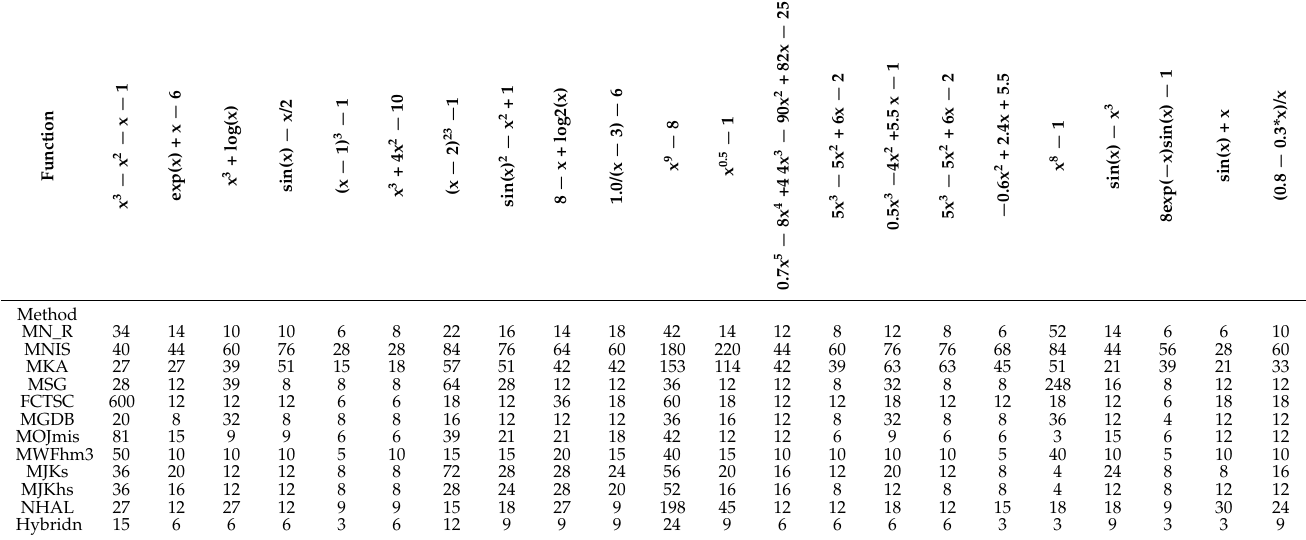
Table 2. One Parameter. Comparison of overall number of function evaluations (NOFE) in hybrid algorithm and all other algorithms on all functions for the number of function evaluations required for the